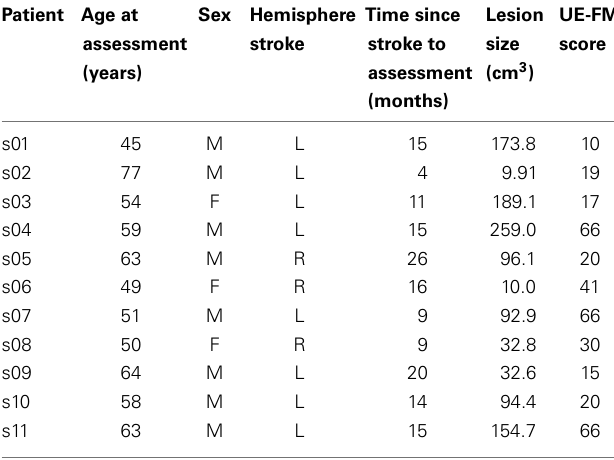
Frontiers in Neurology |